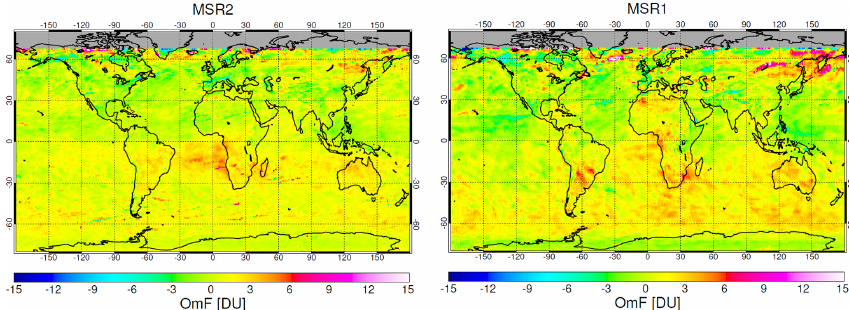
Figure 8. The global distribution, gridded on 1 ◦ × 1 ◦ , of the OmF in Dobson units of the MSR2 data set averaged for the month January 2008 (left panel). The MSR2 data for this month are based on satellite observations from SBUV, GOME, SCIAMACHY, GOME2 and OMI. The right panel shows the same OmF distribution for the MSR1.